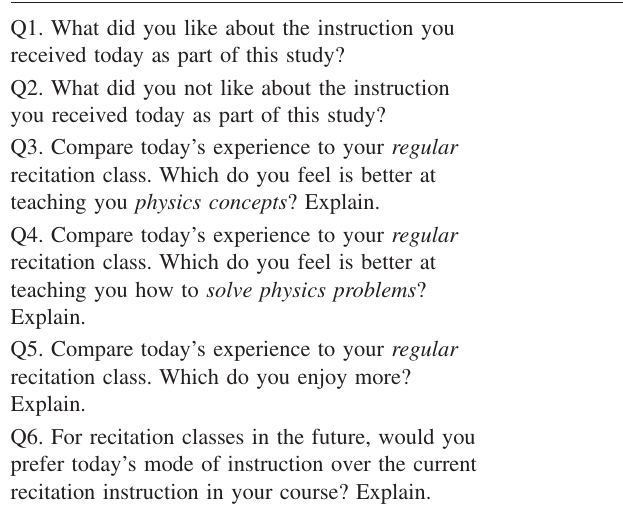
TABLE I. Attitude survey questions. TABLE II. Student performance on the pretest